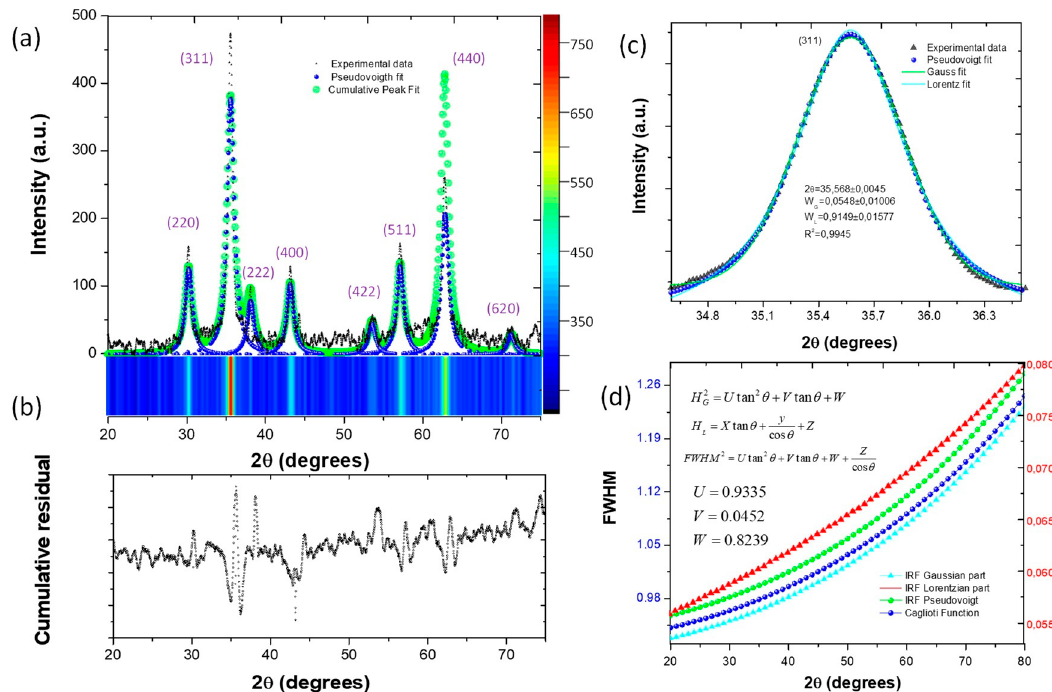
Figure 3. ( a ) XRD pattern profile fitting and pseudo-Voigt analysis of broadening. ( b ) Cumulative residual fitting peak ( c ) Fitting intensity of the (311) plane of the magnetite and ( d ) convolution of the instrumental resolution function (IRF)